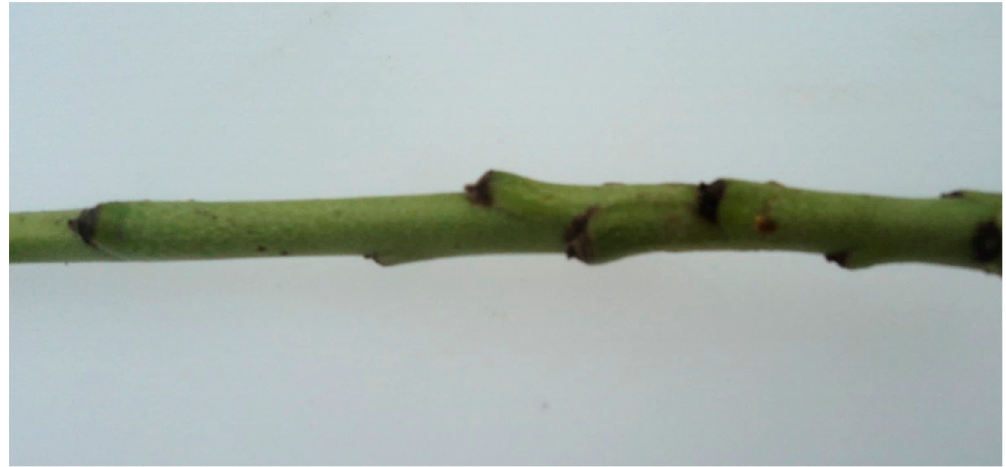
Figure 5. “Blind nodes” in a peach twig, resulting of flower bud abortion due to high temperatures during the differentiation process.